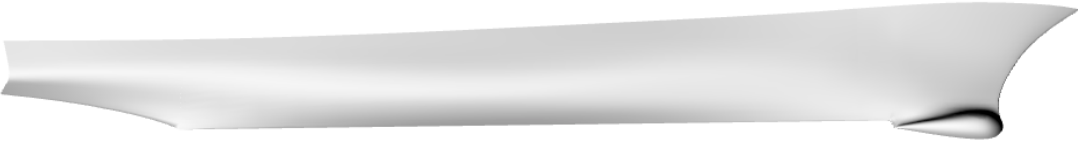
Figure 10. Schematic of a 3D model of DTMB 5415.